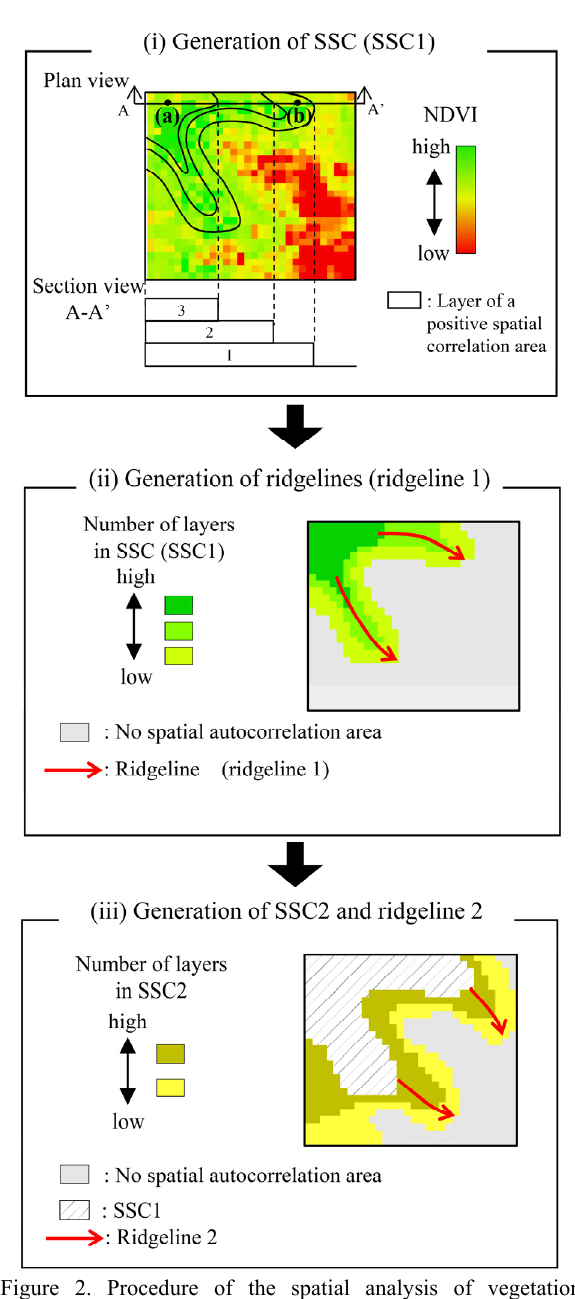
Figure 2. Procedure of the spatial analysis of